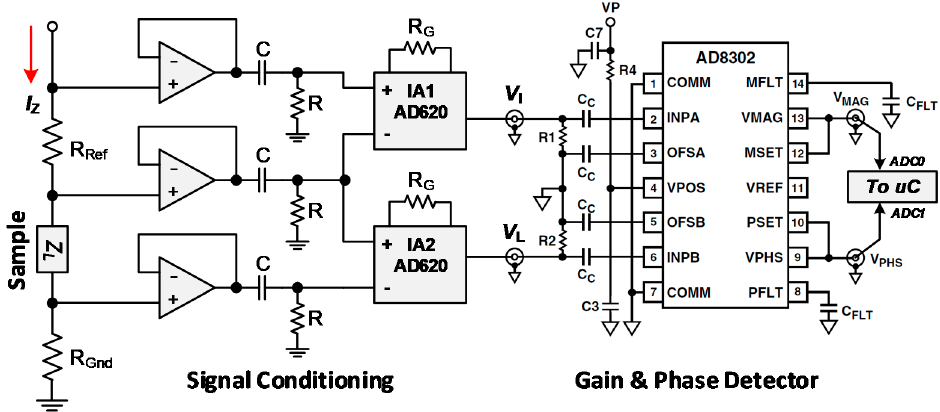
Figure 4. Data acquisition system: signal conditioning (SC) and gain-phase detector (GPD) .